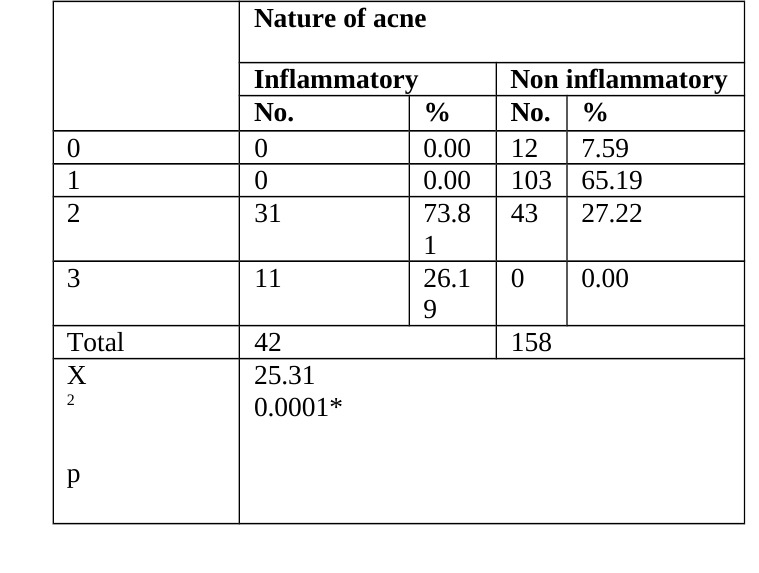
Figure.(11): Relation between GAAS in group I at end of follow up and nature of